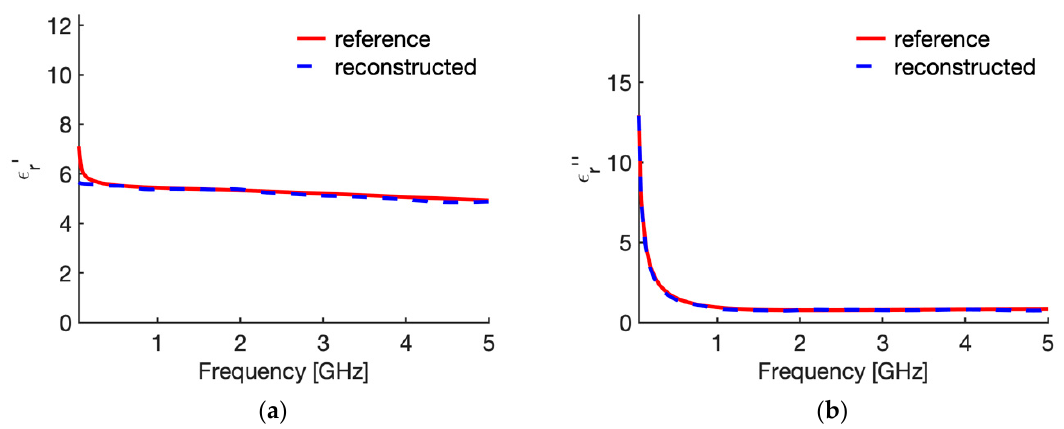
Figure 4. Percentage errors in the evaluation of the relative complex permittivity of liver at 25 °C through the reflection arrangement of the open probe technique ( a ) real part; ( b ) imaginary part.